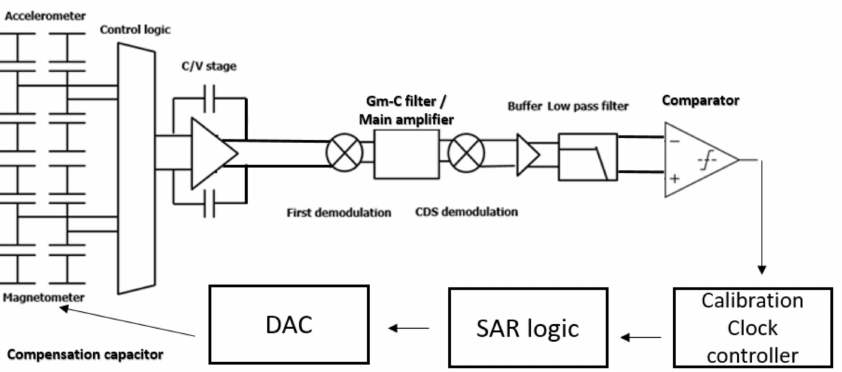
Figure 7. The overall architecture of the proposed readout system. Capacitance-to-voltage (C/V) circuit; successive approximation register (SAR) logic; digital-to-analog converter (DAC); the opera- tional transconductance amplifier-capacitor (GM-C)